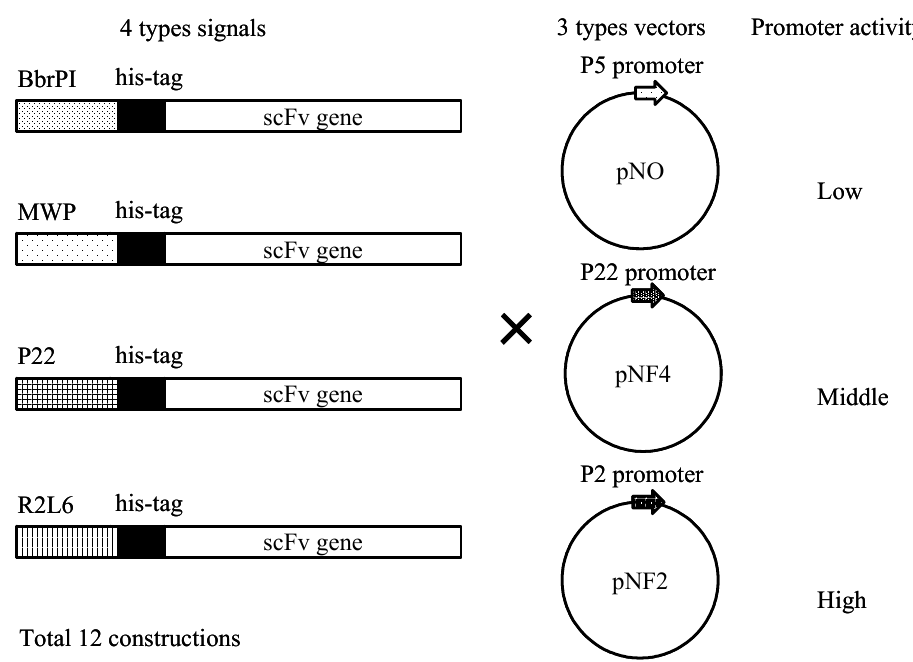
Figure 4. Schematic illustration of His-scFv expression constructs. Secretion signals, His-tag and the scFv gene are schematically drawn. Three types of vectors, pNO, pNF4 and pNF2, are